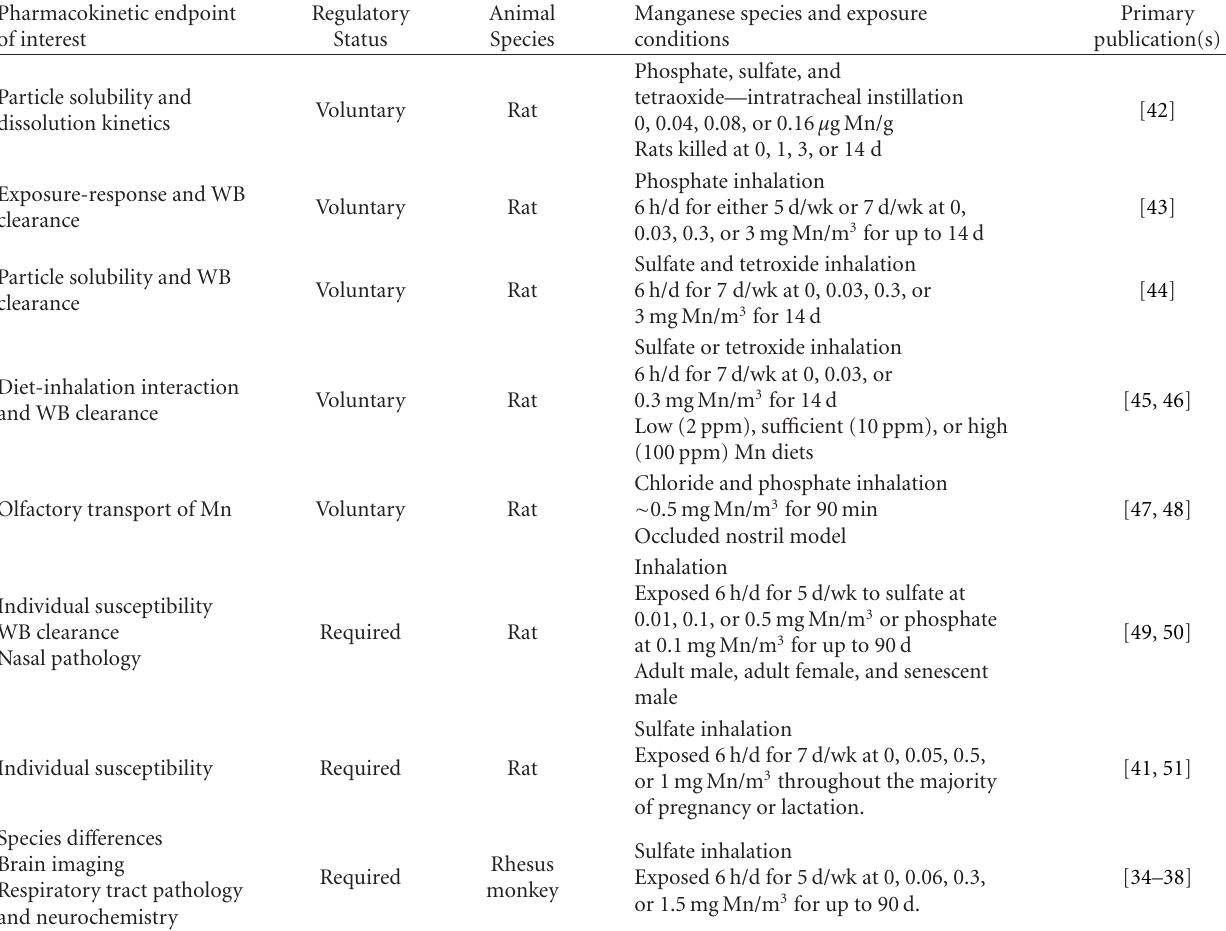
Table 1: Overview of the pharmacokinetic studies conducted in response to the Alternative Tier 2 test program for MMT. The following forms of manganese (Mn) were used in these studies: Mn tetroxide, Mn sulfate, and Mn phosphate. Some studies also involved